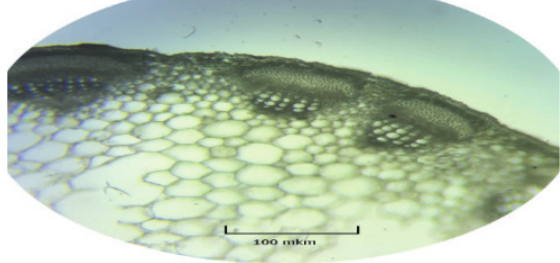
Figure 4. T. pratense stalk (cross section)